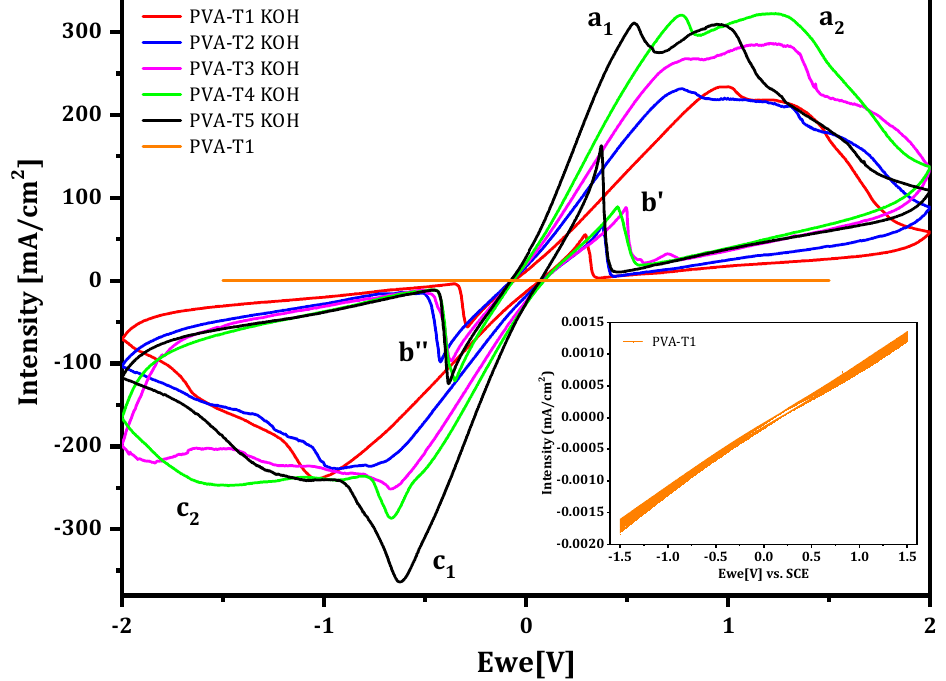
Figure 9. Comparison of the cyclic voltammetry of PVA-VAVTD and GPEs immersed in KOH 12M at different VAVTD contents. Inset: cyclic voltammetry of PVA-T1 membrane. Peak labels are explained in the text.